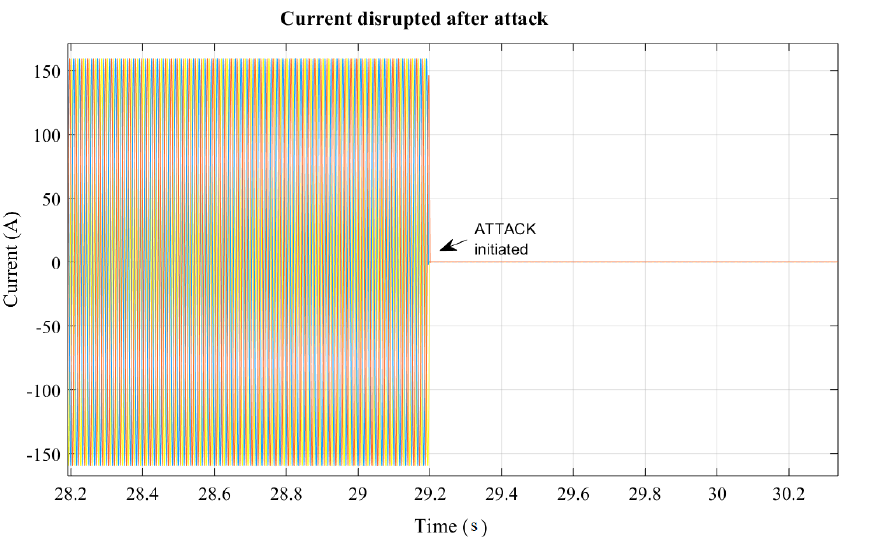
Figure 11. Disruption in the current measurement after injection attack.